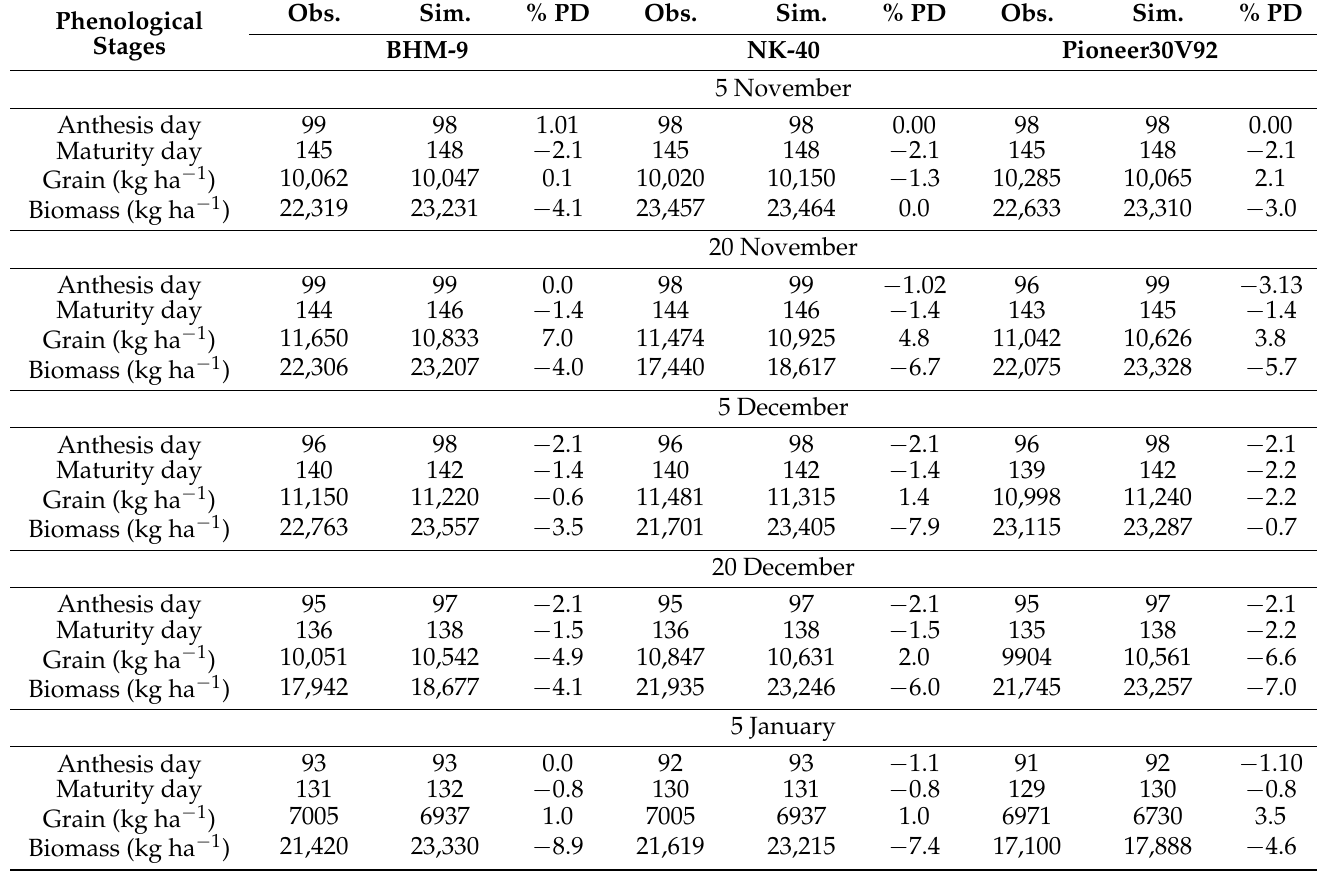
Table 6. Comparison between observed and simulated, and percent differences for phenological development stages, grain, and biomass yields as affected by different sowing dates and maize hybrids with the CERES-Maize model at Rangpur, Bangladesh during